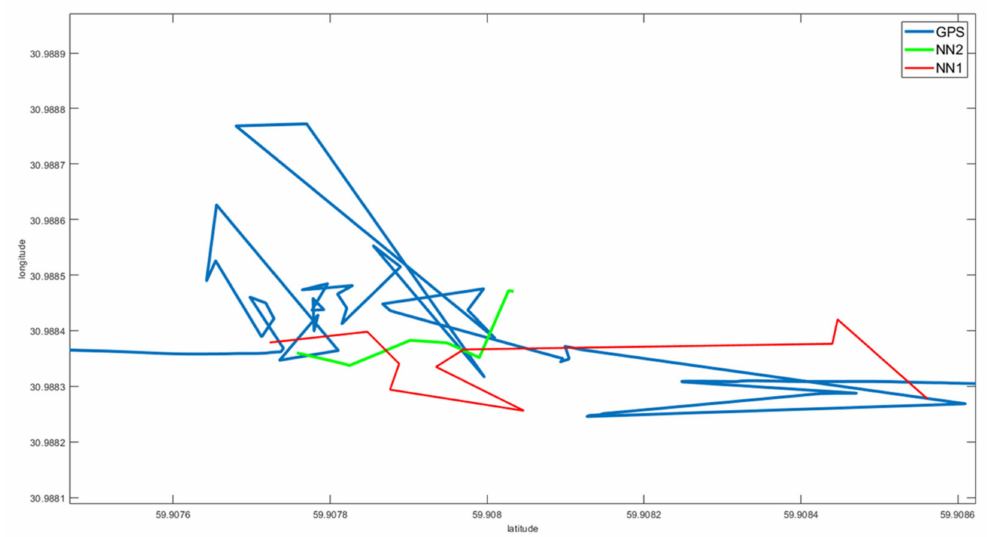
Figure 11. Comparison of the trajectories predicted by considered neural networks with the reference trajectory along the path with data loss and